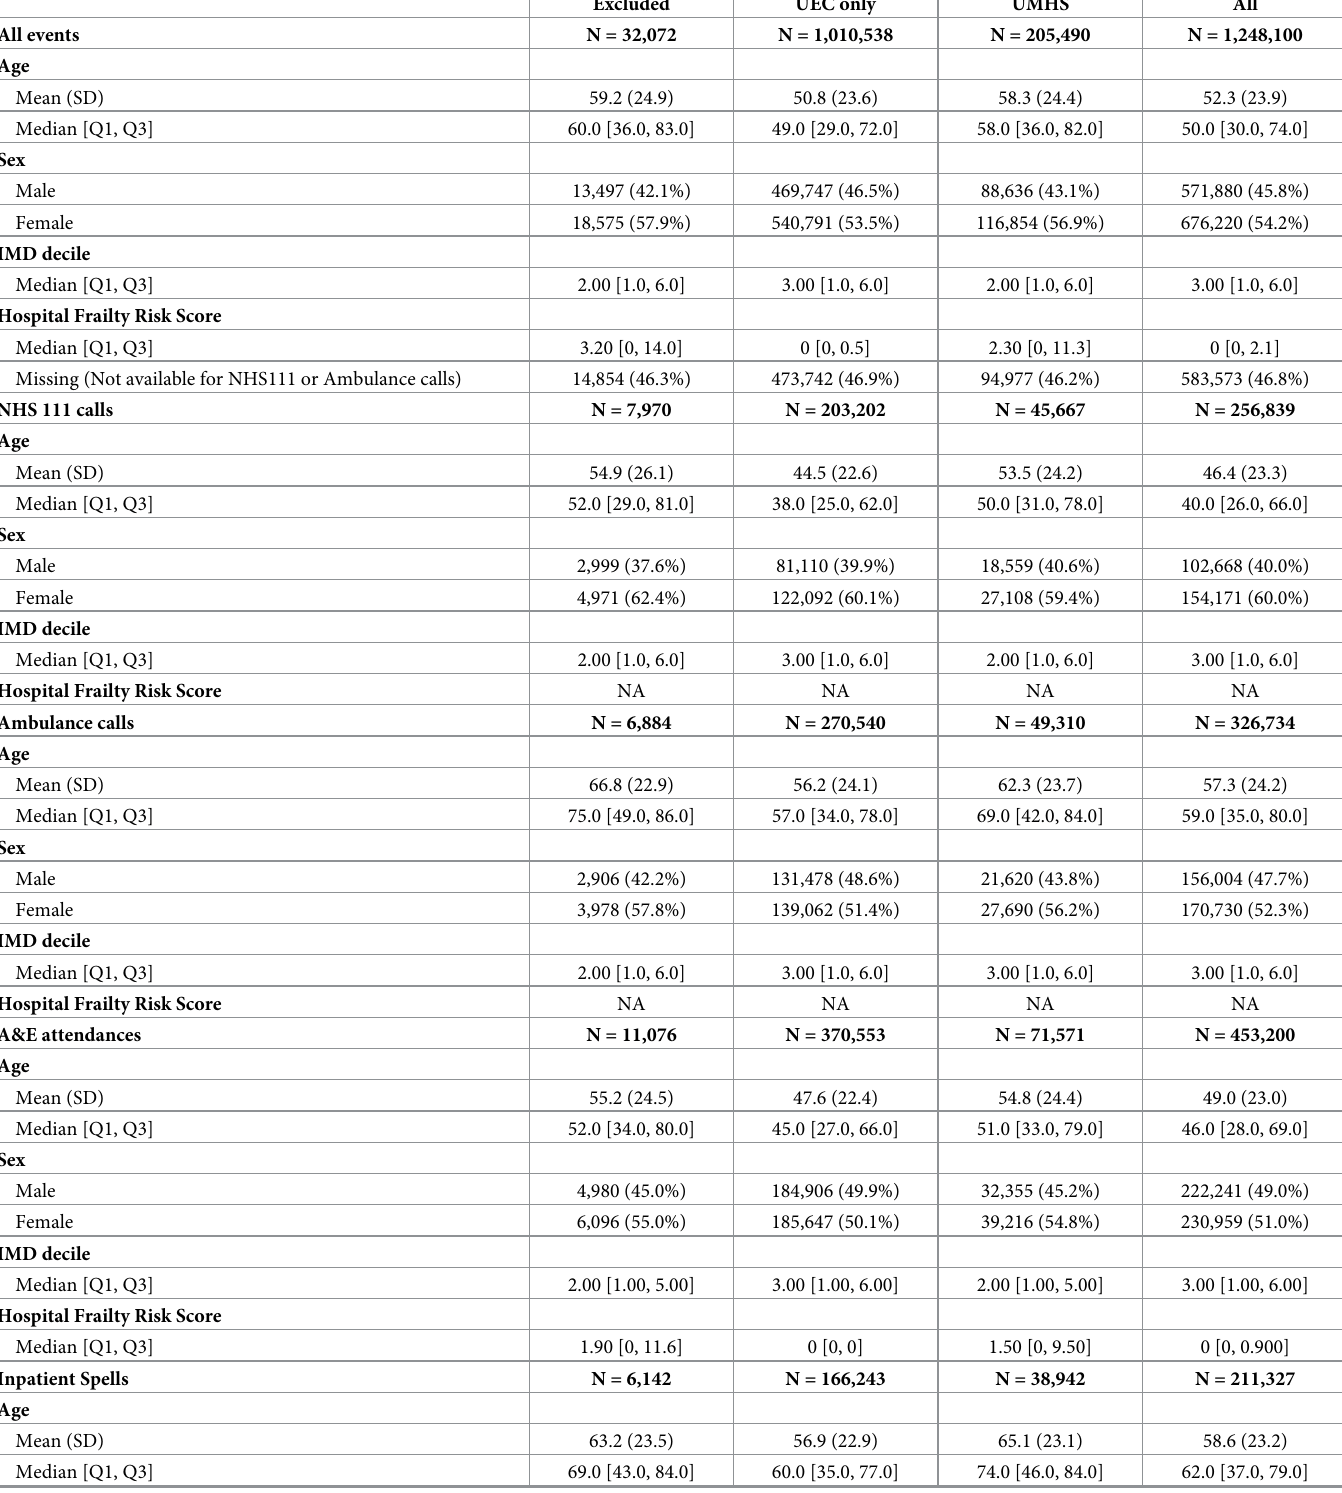
Table 1. User characteristics for all UEC contact events during the study